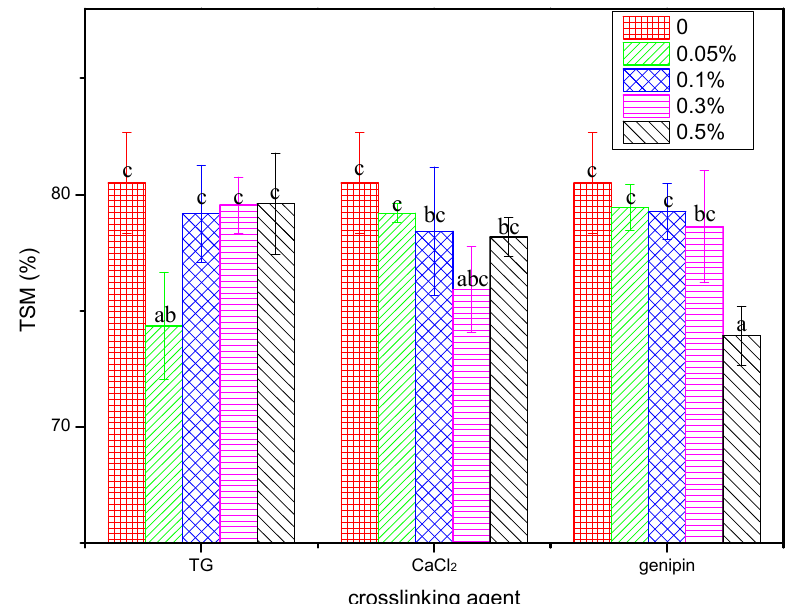
Figure 4. The total soluble masses of the blend films. Different lowercase letters indicate significant differences ( p < 0.05).